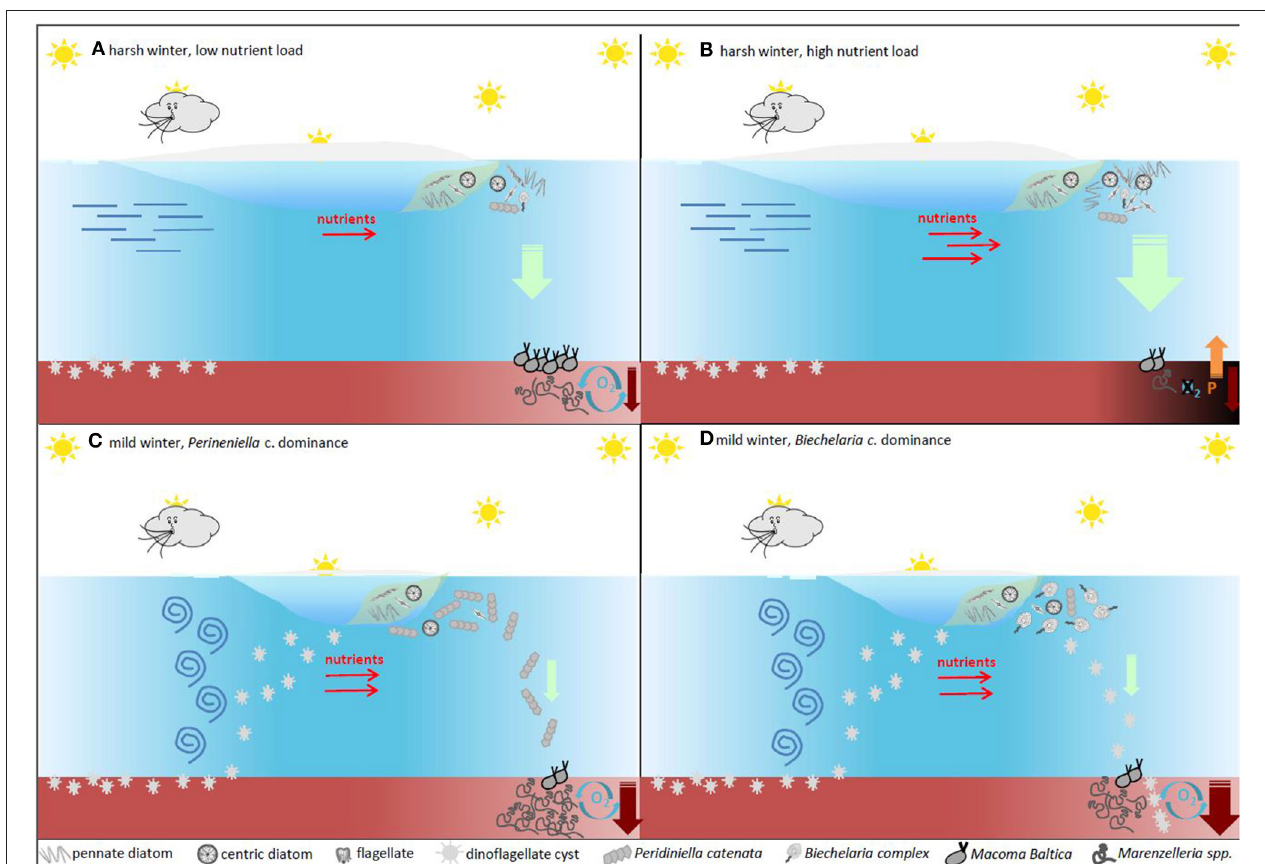
FIGURE 6 | A conceptual model of how the main spring phytoplankton groups affect sedimentation patterns and biogeochemical cycling of nutrients. The primary driver for the onset of the spring bloom is the availability of light, which is mainly governed by the mixing/stabilization of the upper parts of the water column. In the Baltic Sea large outflow of freshwater during spring creates patches of stratified water where the bloom initiates. After the spring bloom, diatoms tend to sink quickly to the seafloor where the biomass is remineralized. The sediment processes will depend on the amount of settling material and eutrophication have shifted the pristine state (A) towards a deteriorated environmental state with release of nutrients from the sediments (B) . Dinoflagellates on the other hand tend to lyse before reaching the sediment (C) with the exception of resting cysts (D) . These resting stages (some species of diatoms also produce large quantities of resting stages with the same function) are built for long term survival and are not remineralized in the sediment on a seasonal basis. Some of the resting stages are buried in the seafloor, providing a biological sink for organic nutrients. The size of this sink largely depends on the species composition of phytoplankton during the productive spring